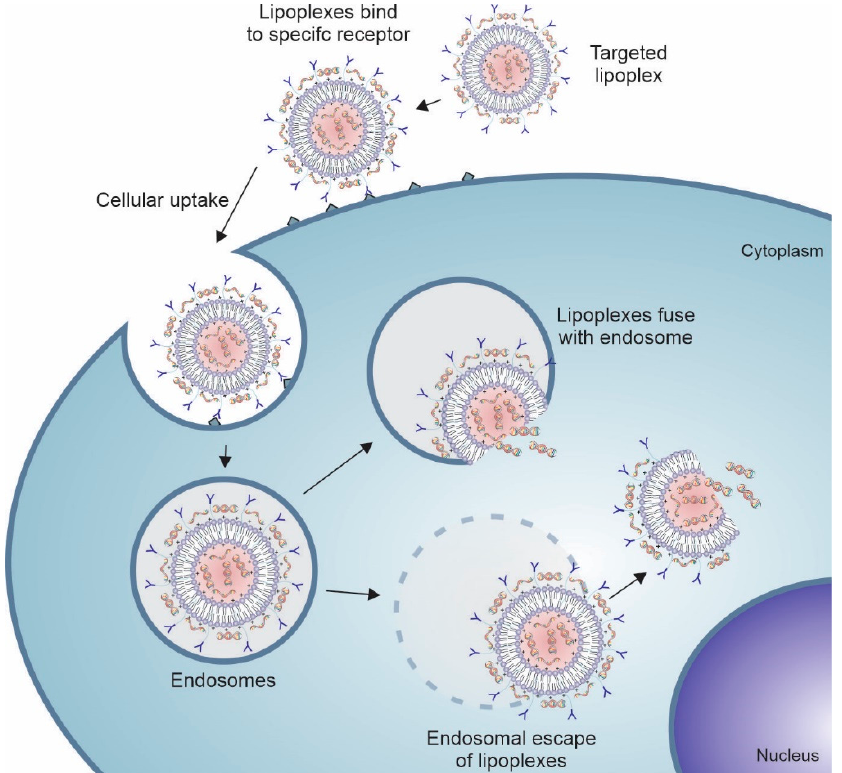
Figure 3. Schematic representation of the cellular uptake of targeted lipoplex and release of NAs into tumor cells. After internalization, lipoplex can fuse with the endosomes or destabilize de endosomes, leading to the release of NAs into the cytoplasm.